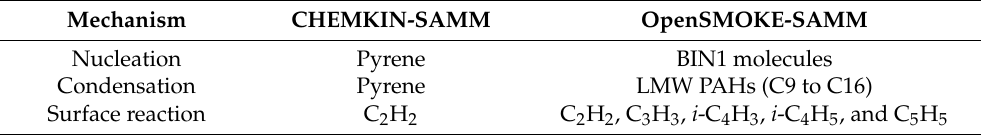
Table 1. Soot precursor species for different gas-to-particle mechanisms. Mechanism